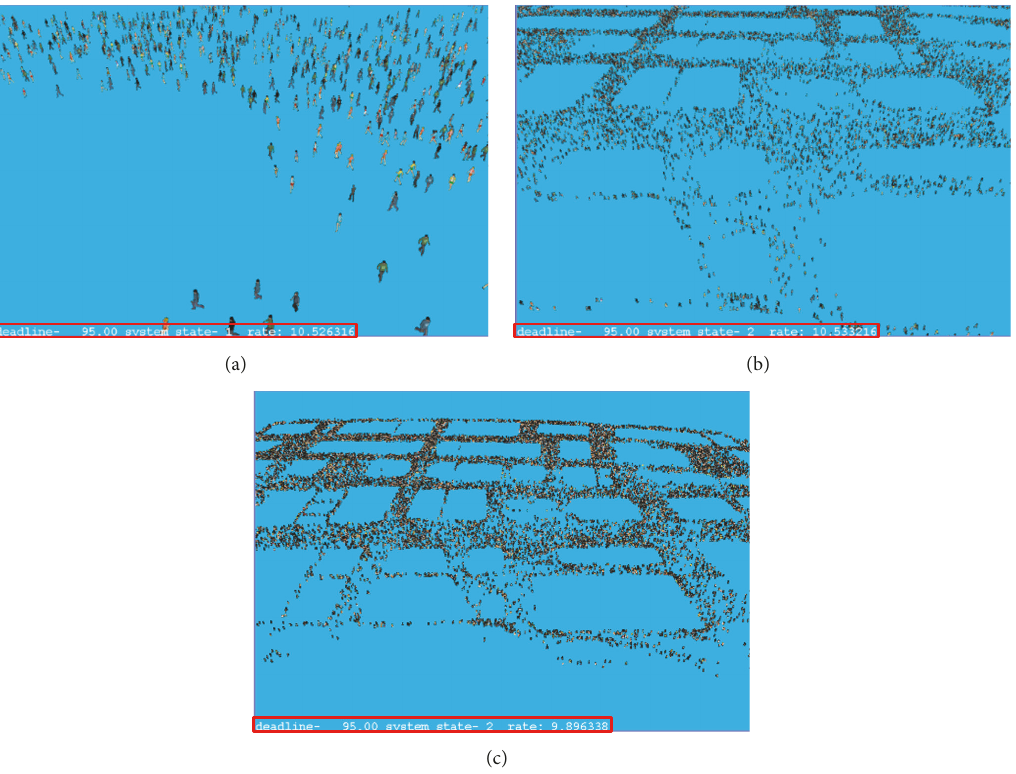
Figure 10: Scenes with three different viewpoints. (a) Close range view. (b) Medium range view. (c) Remote range view.